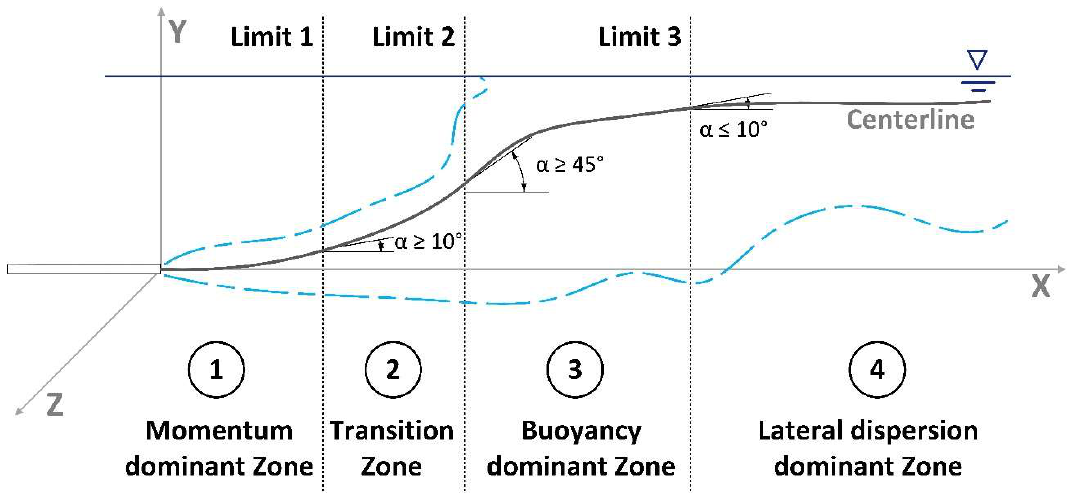
Figure 3. Proposed zonation of positively buoyant jets using the angle ( α ) shaped by the tangent of the centerline trajectory and the longitudinal axis ( X -axis).